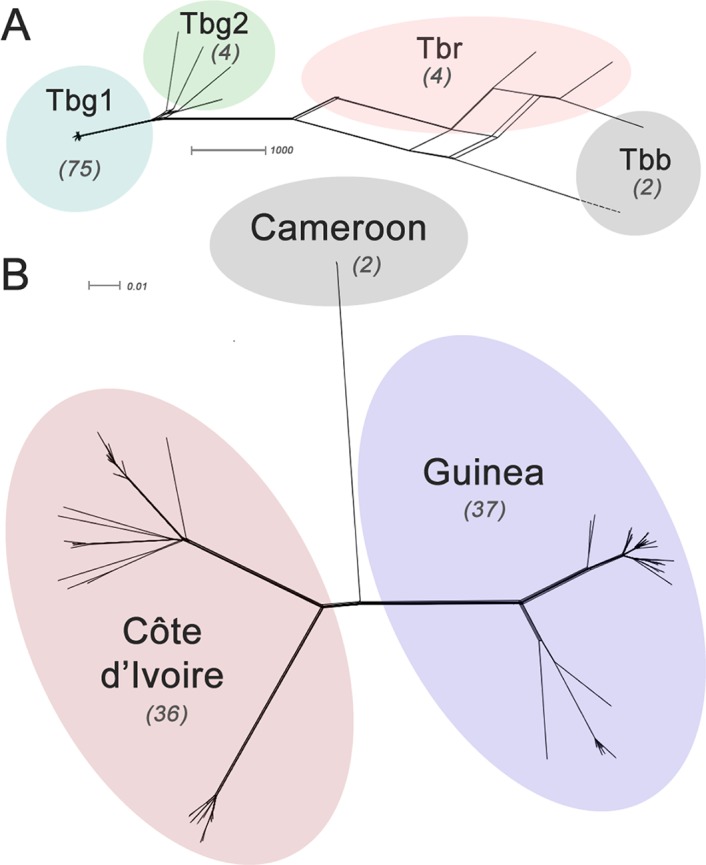
Phylogenetic network analysis.SplitsTree phylogenetic networks were constructed using (A) each isolate for the collection of T.b. brucei (Tbb), T.b. rhodesiense (Tbr), T.b. gambiense Group 1 (Tbg1) and T.b. gambiense Group 2 (Tbg2) and (B) for just T.b. gambiense Group 1 isolates. The number of samples in each group is indicated in parenthesis.DOI:
http://dx.doi.org/10.7554/eLife.11473.00310.7554/eLife.11473.004Figure 1—source data 1.Number of SNP loci with respect to different sub-species.DOI:
http://dx.doi.org/10.7554/eLife.11473.00410.7554/eLife.11473.005Figure 1—source data 2.Testing Hardy-Weinberg Equilibrium (HWE) across the T.b. gambiense Group 1 genome.DOI:
http://dx.doi.org/10.7554/eLife.11473.00510.7554/eLife.11473.006Figure 1—source data 3.FIS by sub-population.DOI:
http://dx.doi.org/10.7554/eLife.11473.00610.7554/eLife.11473.007Figure 1—source data 4.Number and type of T.b. gambiense Group 1 SNPs.